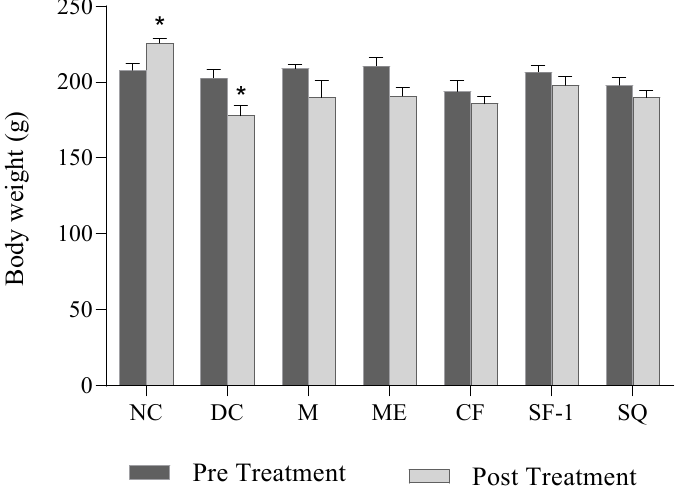
Figure 4. Effects of S. polyanthum on the body weights of streptozotocin-induced diabetic rats. All treatments were administered orally twice daily for 12 days as follows: NC, normal control (saline, 10 mL/kg); M, metformin (500 mg/kg); DC, diabetic control (saline, 10 mL/kg); ME, methanol extract (1 g/kg); CF, chloroform fraction (500 mg/kg); SF-1, n -hexane fraction (250 mg/kg); SQ, squalene (160 mg/kg). The values are expressed as mean ± SEM ( n = 6). * indicates significant differences between pre-treatment (day 0) and post-treatment (day 12) of the same group as analyzed by using the paired t -test (* p < 0.05).